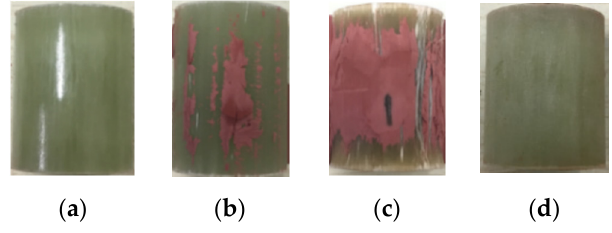
Figure 15 . Core rod after stripping sheath: ( a ) NN1; ( b ) YY1; ( c ) YN1; ( d ) NY1.